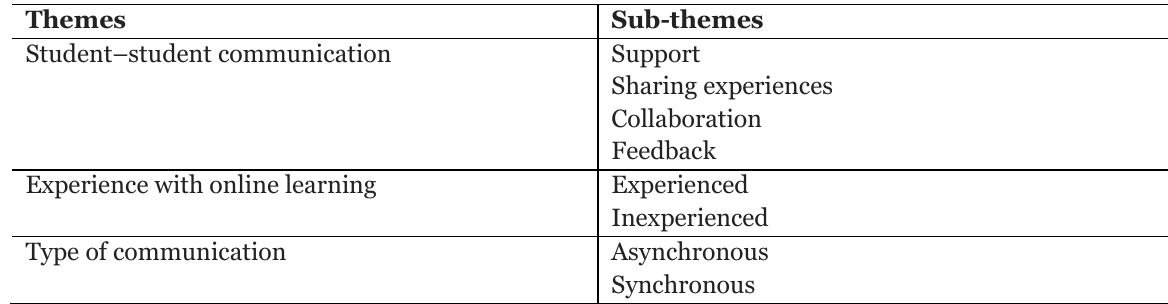
Sample of Thematic